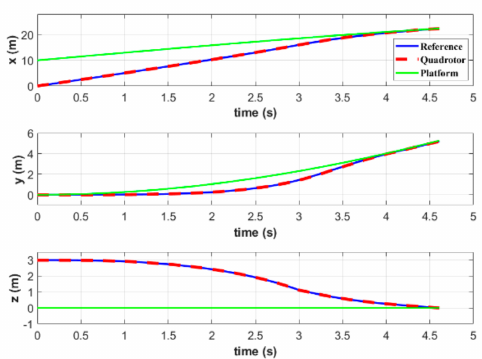
Figure 13. Positions of the quadrotor and platform in simulation